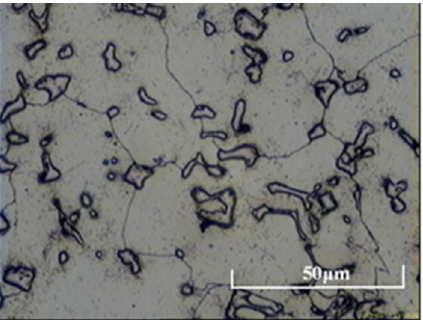
Figure 4. Microstructure of high-manganese cast steel with the addition of 5.5% V after solution heat treatment with water quenching, Nital etching, [5].